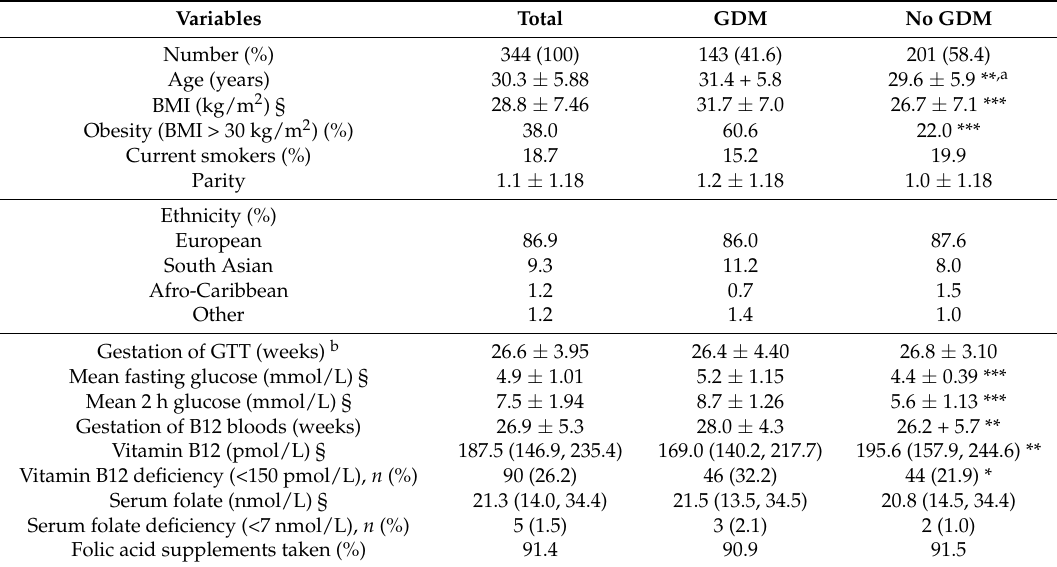
Table 1. Maternal characteristics according to GDM